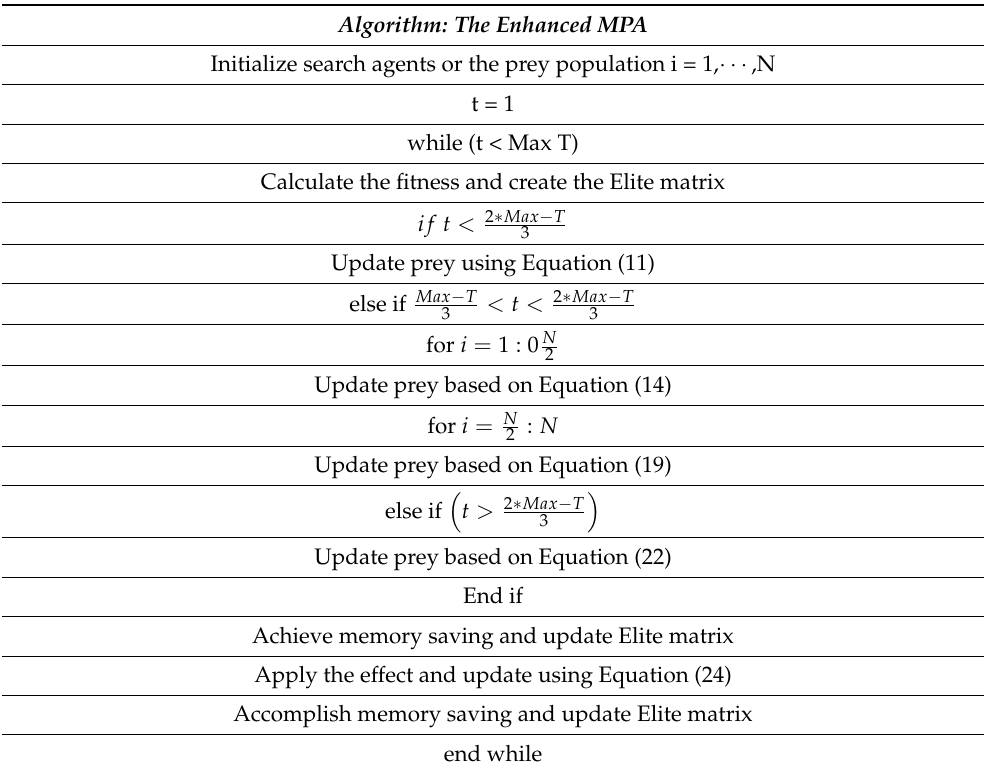
Table 3. Enchased MPA Algorithm Matrix. Algorithm: The Enhanced